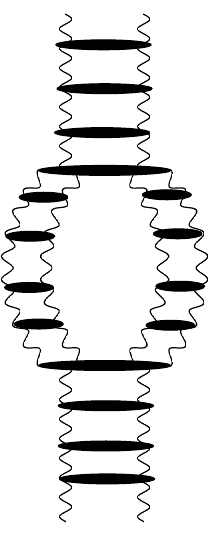
Figure 3 . Pomeron